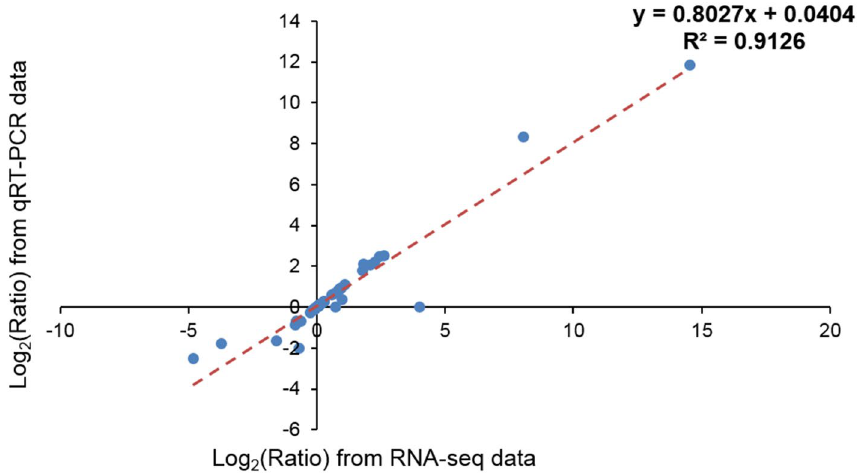
Figure 10. The correlation between qRT-PCR and the transcriptome data as shown by values of log 2 (relative expression ratios) in qRT-PCR (x-axis) plotted against the values of log 2 (RPKM ratios) in transcriptome data (y-axis) for the 12 candidate